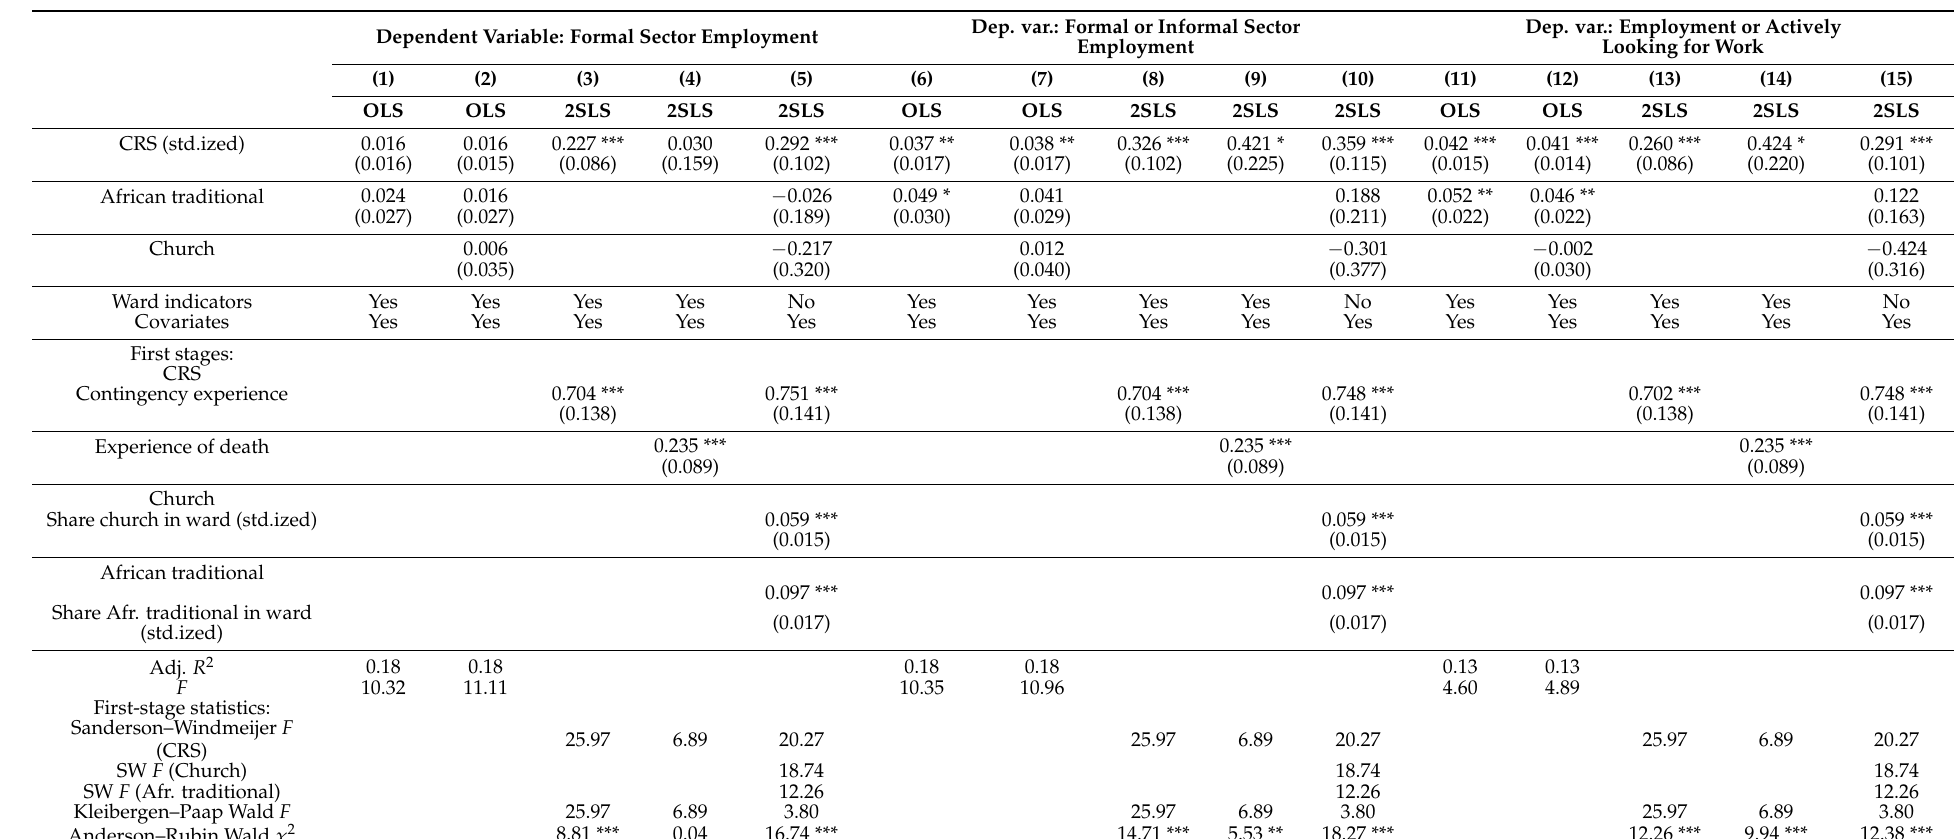
Table A4. Estimation results linear probability